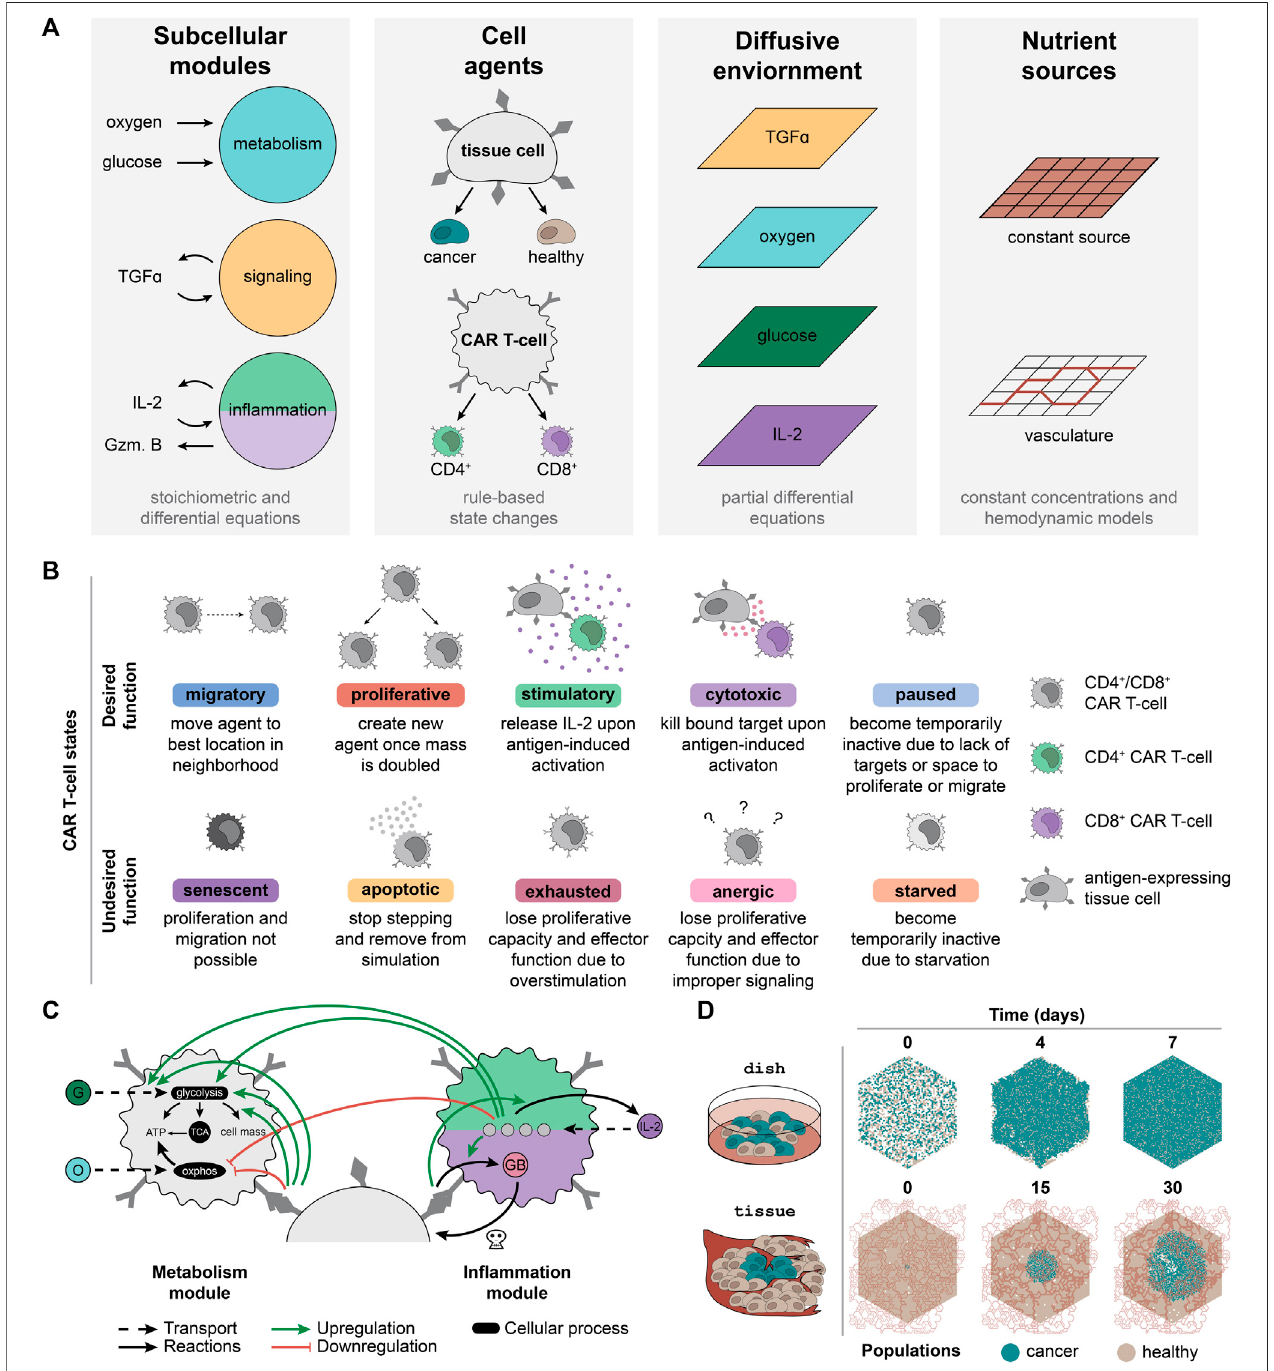
FIGURE 1 | CARCADE structure and CAR T-cell agent design. (A) Depiction of CARCADE components. Subcellular modules guide underlying cellular function to in fl uencebehavior(Gzm.B,granzymeB).AgentsincludetissuecellandCART-cellagents,eachofwhichhasseparaterulesetsandisdepictedwithsurfaceligandsand CARs(dark gray).Tissuecellsinclude bothhealthycellsandcancercells. Agentsexistinanenvironmentwherediffusioniscontrolledbypartialdifferential equationsand constant sources or vasculature provide nutrients. (B) Descriptions of each CAR T-cell agent state, separated by whether the state is desired or undesired for ef fi cacious treatment. (C) Diagram of CAR T-cell metabolism and in fl ammation module interactions with small molecules, proteins, and regulatory edges. The in fl ammationmodulediagramisbrokenintotwoparts,showingdifferencesbetweenCD4 + CART-cells(lightgreen,top)andCD8 + CART-cells(purple,bottom).AllCAR T-cells use identical metabolism modules. Regulatory edges (upregulation: green arrow, downregulation: red fl athead arrow) result from IL-2 binding and antigen- induced activation. G, glucose; O, oxygen; GB, granzyme B; OXPHOS, oxidative phosphorylation. Legend for cell color is consistent with panel B. (D) An example of a single dish and tissue simulation of untreated cancer and healthy cells shown at select time points. For tissue , the dynamic vasculature architecture is overlaid.